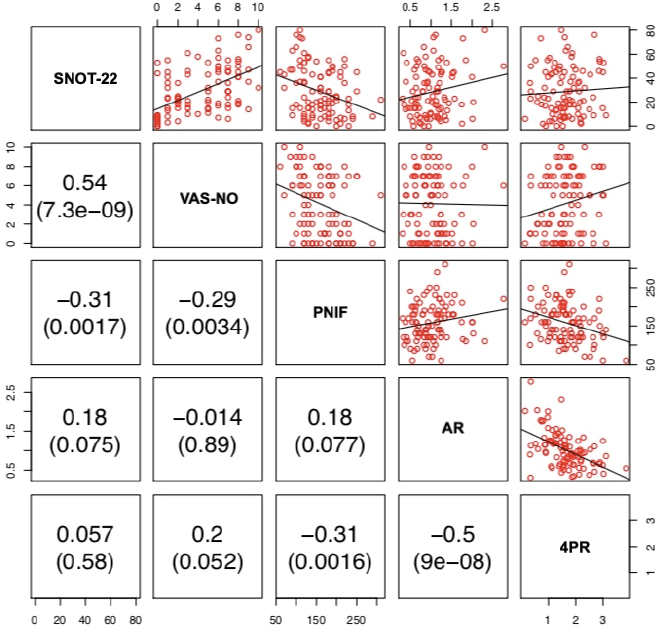
Figure 1. Correlation between SNOT-22, VAS-NO, bilateral PNIF, AR and 4PR. PNIF: Peak Nasal Inspiratory Flow; AR: acoustic rhinometry; 4PR: 4-Phase Rhinomanometry; SNOT-22: Sinonasal Outcome Test-22; VAS-NO: Visual Analogue Scale for Nasal Obstruction.